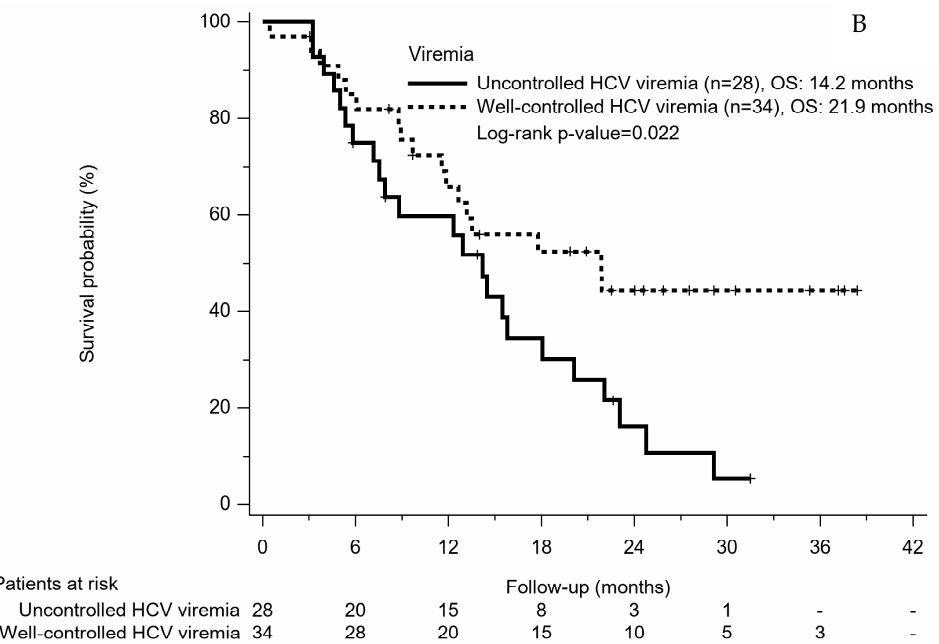
Figure 4. ( A ). Overall survival rates based on HBV infection and viremia-control status. ( B ) Overall survival rates based on HCV infection and viremia-control status.